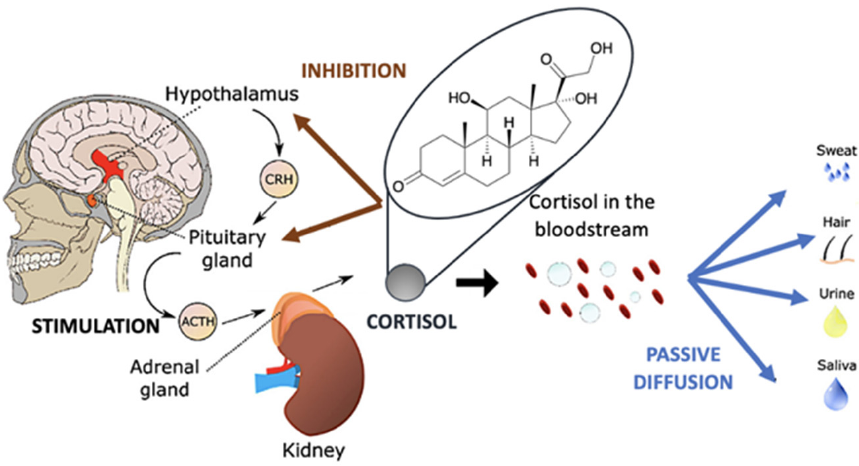
Figure 1. Mechanism of cortisol generation in the human body. Free cortisol is released into the bloodstream and diffused to different tissues (adapted with permission from [17]. Copyright 2020 Elsevier). Table 1. Cortisol levels in different biological samples in nominally healthy subjects. Adapted with permission from [17]. Copyright 2020 Elsevier.